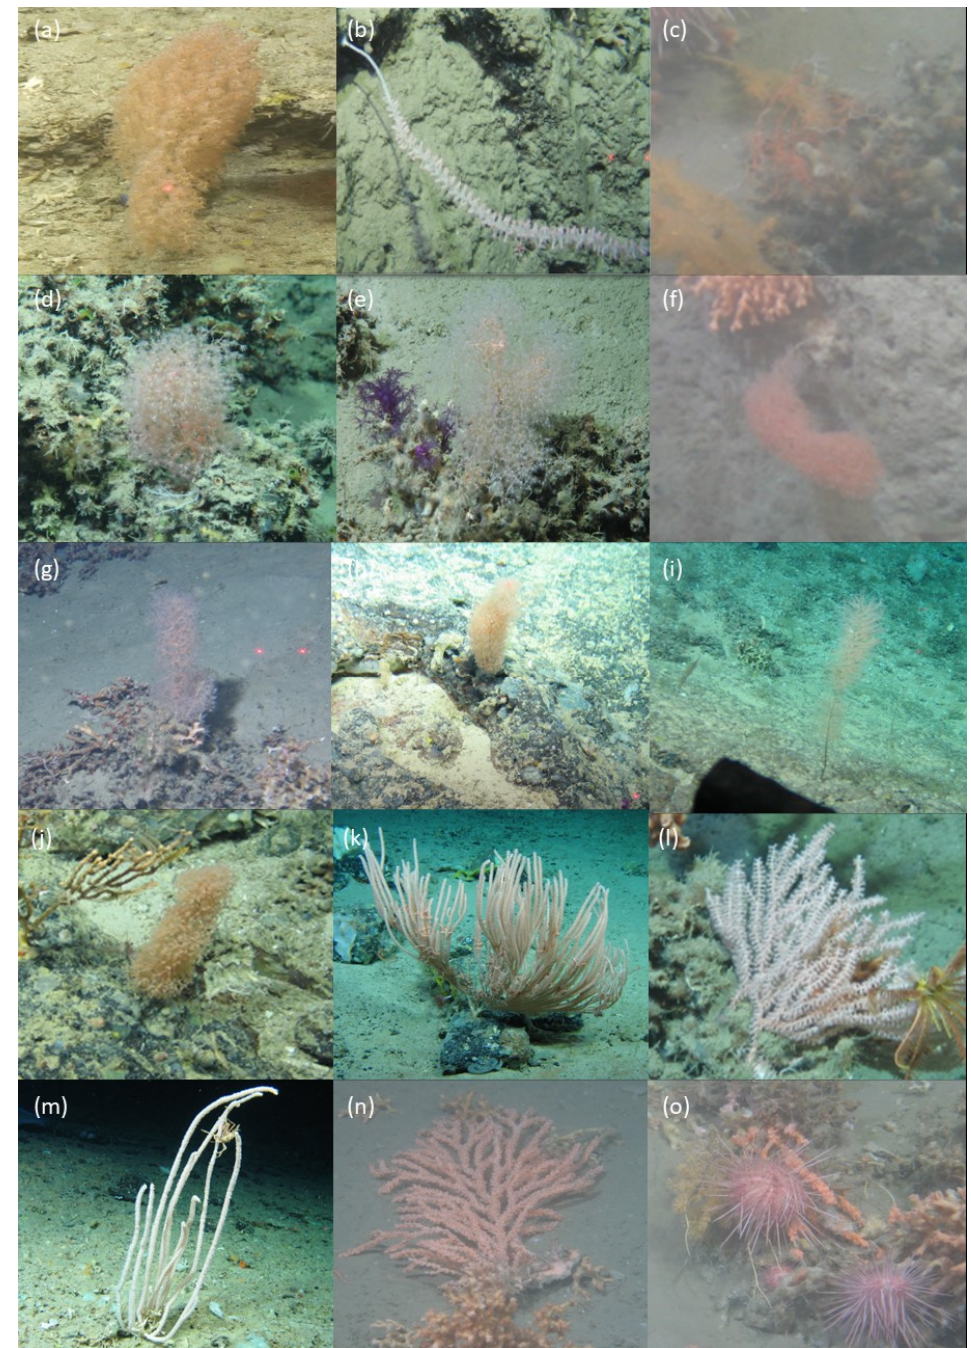
Figure 4. In situ photographs taken by ROV Holland I representing the gross morphology of ( a ) Haplotype 22 Acanella sp. (M27), ( b ) Haplotype 23 (M14), ( c ) Haplotype 24 Chelidonisis aurantiaca (M44), ( d ) Haplotype 25 Chrysogorgia s.l. Group 7 (M37), ( e ) Haplotype 26 Chrysogorgia s.l. Group 7 (M38), ( f ) Haplotype 27 Chrysogorgia s.l. Group 3 (M39), ( g ) Haplotype 27 Chrysogorgia s.l. Group 3 (M40), ( h ) Haplotype 27 Chrysogorgia s.l. Group 3 (M41), ( i ) Haplotype 28 Dasygorgia (M42), ( j ) Haplotype 29 Chrysogorgia s.l. Group 1 (M43), ( k ) Haplotype 30 Narella bellissima (M32), ( l ) Haplotype 31 Candidella imbricata (M34), ( m ) Haplotype 32 Narella versluysi (M33), ( n ) Haplotype 33 Primnoa sp. (M31) and ( o ) Haplotype 34 Primnoa sp. (M31).